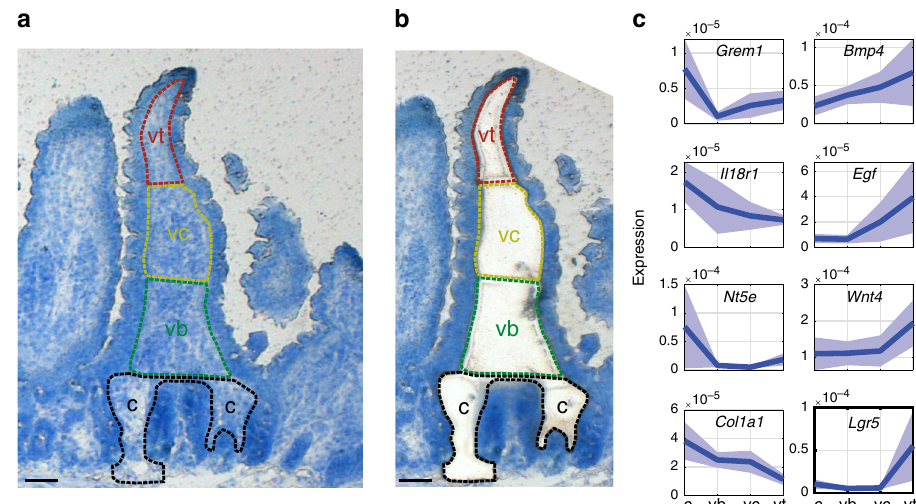
Fig. 1 Spatial transcriptomics of the intestinal stroma. a – b LCM of four zones along the crypt-villus axis before ( a ) and after ( b ) laser dissection. c – crypt, vb – villus bottom, vc – villus center, vt – villus tip. Scale bar – 50 µ m. c Representative spatial LCMseq expression pro fi les of stromal ligands and receptors zonated towards the crypt (left) or villus tip (right). Units are fraction of sample mRNA, patches are